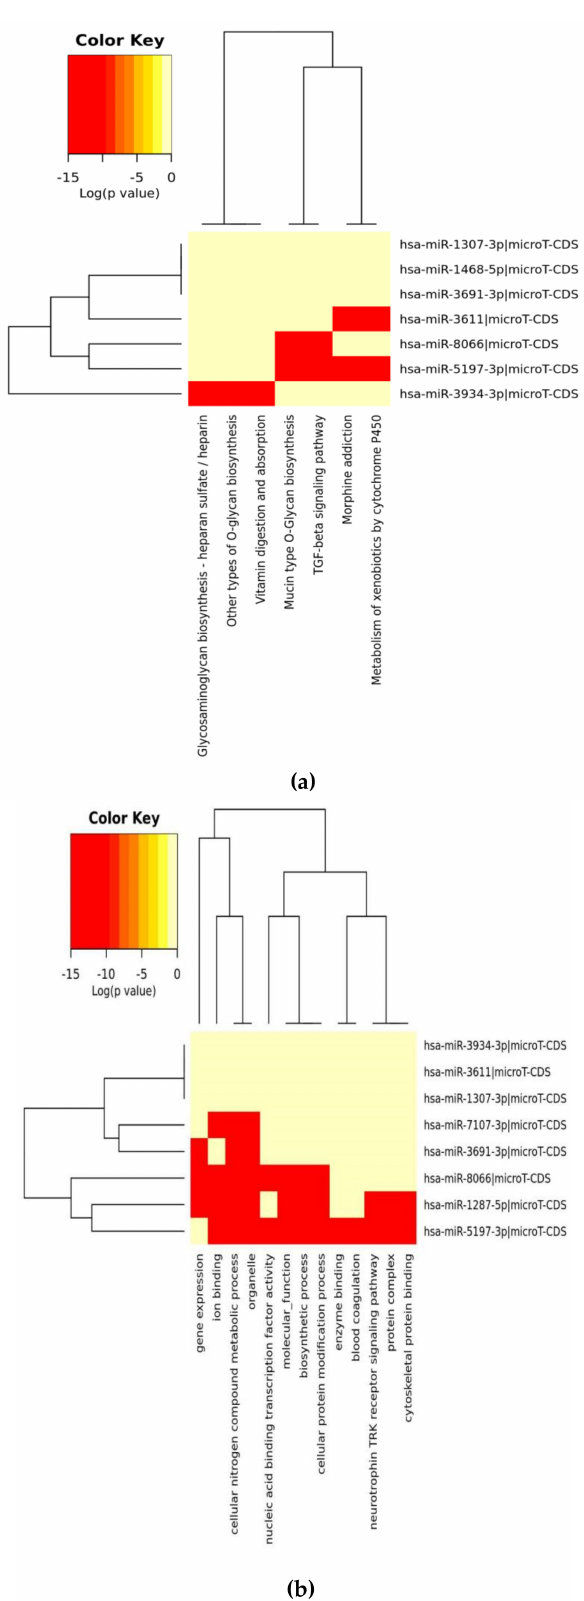
Figure 1. Heat map analysis of KEGG pathway ( A ) and GO analysis ( B ) for selected miRs on the microT-CDS database. The heat map is drawn with miRPATH (version 3). Neighbourhood lines indicate the shared target mRNAs found in a defined